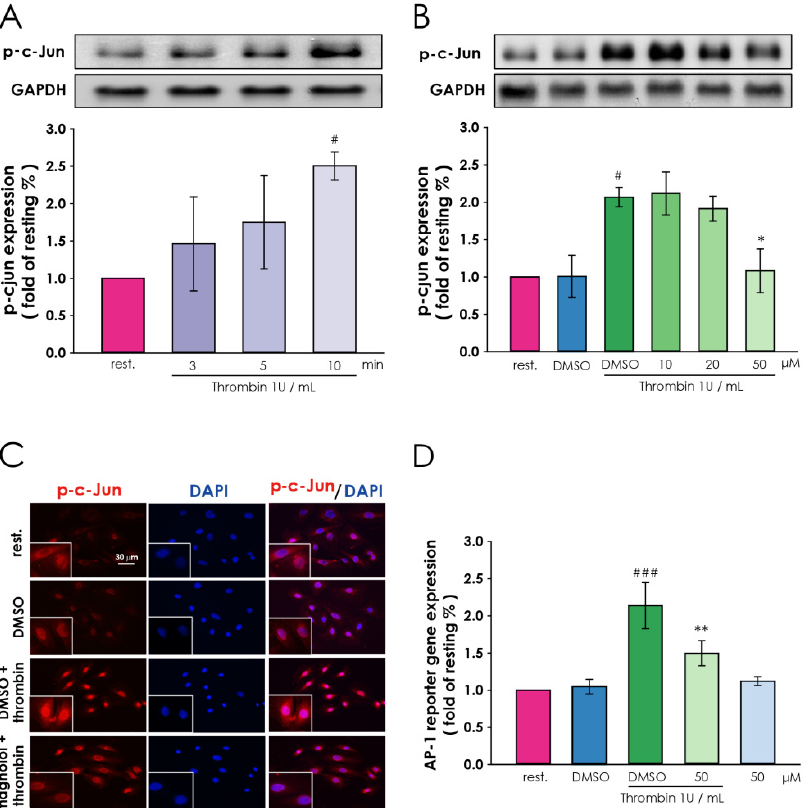
Figure 4. Interference by magnolol in thrombin-induced downstream signal transduction, including c-Jun and AP-1 in A10 cells. ( A ) 6 h after serum-starvation, A10 cells were treated with thrombin (1 U/mL) to assess the time course of thrombin-induced c-Jun phosphorylation ( B ) 6 h serum-starved A10 cells were incubated with magnolol (10–50 µ M) or 0.05% DMSO for 90 min and then thrombin (1 U/mL) treatment for 10 min. Western blotting was then used to determine the level of p-c-Jun under each condition. ( C ) The location of p-c-Jun (red) was probed using an anti-p-c-Jun antibody, and DAPI